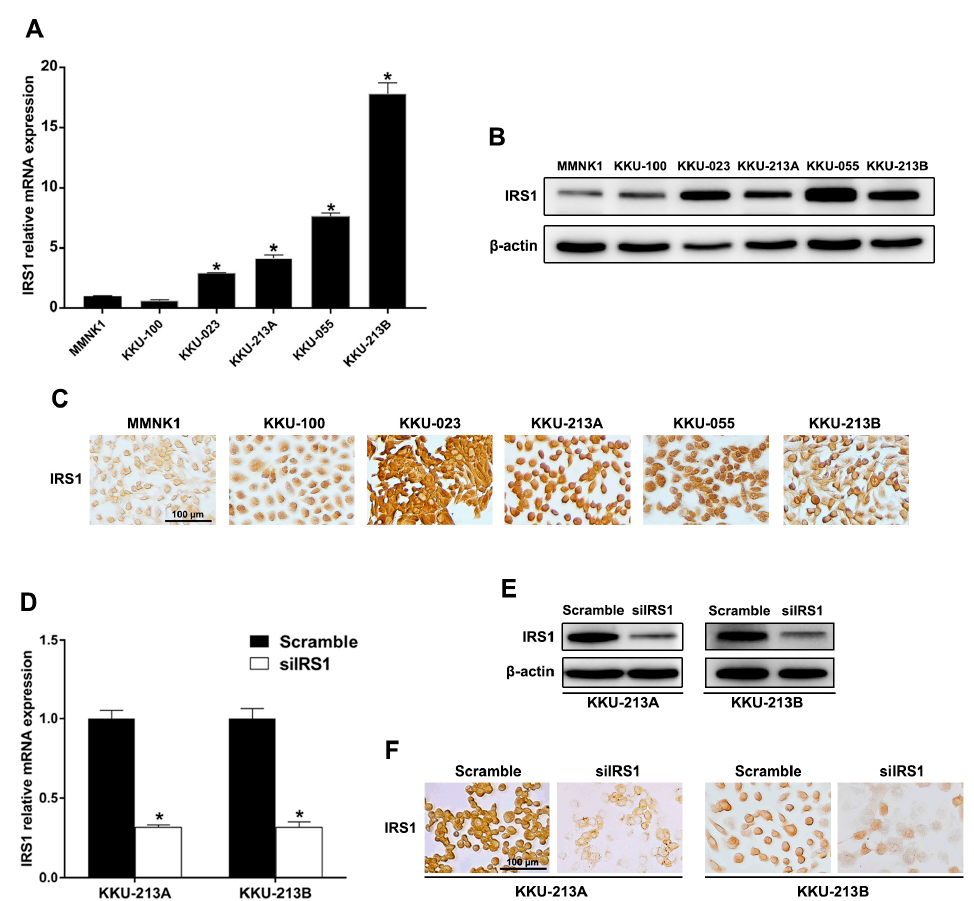
Figure 4. IRS1 expression in human CCA and immortalized cholangiocyte cell lines. ( A ) Relative mRNA levels of IRS1 measured by real-time PCR. * p -value < 0.05 compared to MMNK1. ( B ) Western blot analysis of IRS1 protein. ( C ) Immunocytochemical staining of IRS1 protein. ( D ) Relative mRNA expression of IRS1 in IRS1 knockdown CCA cells (KKU-213A and KKU-213B). * p -value < 0.05 compared to scramble. ( E , F ) IRS1 protein expression in KKU-213A and KKU-213B cells after IRS1 knockdown detected by Western blotting and immunocytochemistry, respectively. Original magnification was 200 × for all micrographs.